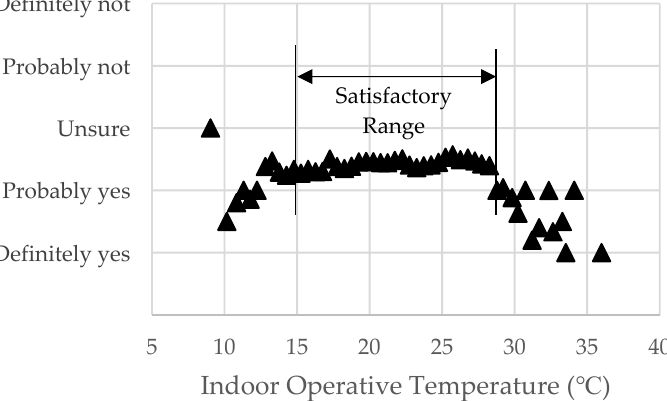
Figure 3. Responses to the question: “Do the conditions in this room influence your health and well-being?” versus binned internal operative temperature (n = 10,813).